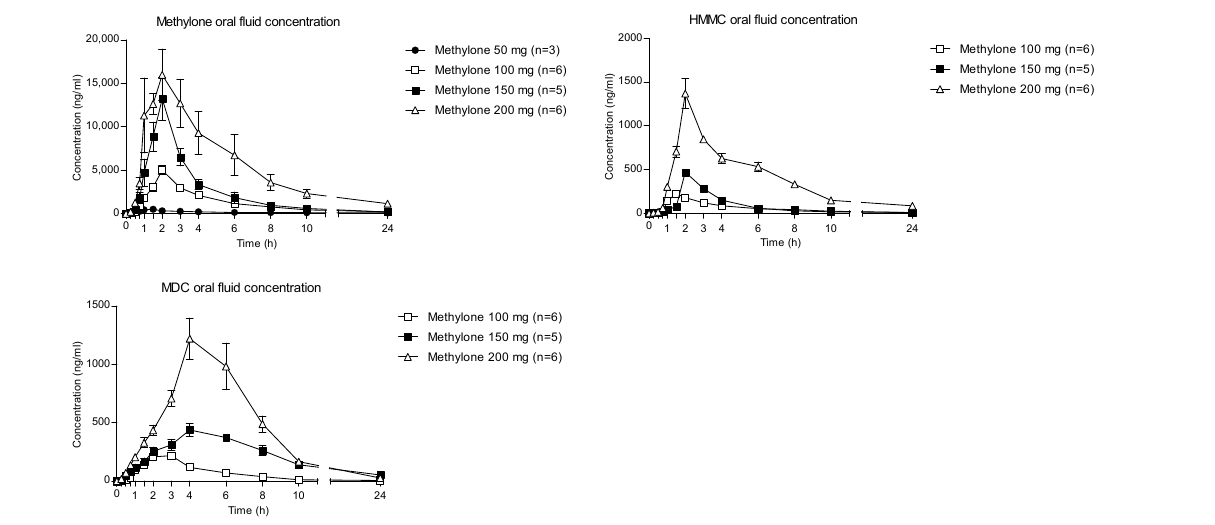
Figure 1. Concentration–time profiles of methylone and its metabolites in OF following controlled administration of different methylone doses.